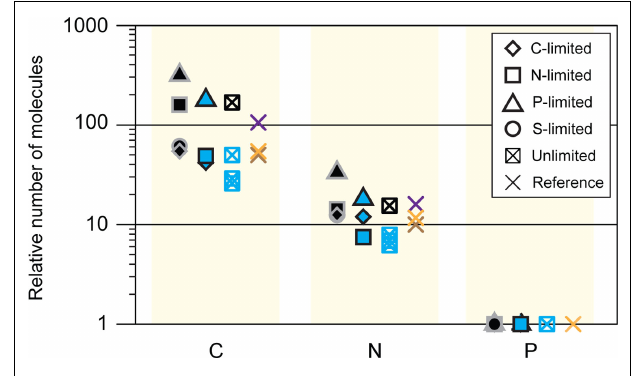
FIGUREA5 | C:N:P ratios from various studies. Black symbols, steady-state R. pomeroyi DSS-3; the unlimited C:N:P ratio was modeled as ∼ 154:15:1 (this study); blue, batch-cultured marine bacterioplankton (Vrede et al., 2002); purple, Redfield ratio, marine seston (Redfield, 1934); brown, natural bacteria (Fagerbakke et al., 1996); orange, natural bacteria (Cotner et al., 1997).